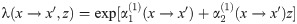
Motion of a single ant on a line.(A) Animals switch between three behavioral states: STOP (gray), UP (blue), and DOWN (red). The transition rates have a form λ(x→x′,z)=exp[α1(1)(x→x′)+α2(1)(x→x′)z] with α1(1)(S→x′)=ln(0.4), α2(1)(S→x′)=0, α1(1)(U→x′)=α1(1)(D→x′)=ln(0.25) and α2(1)(U→x′)=-α2(1)(D→x′)=0.7. A short segment of a sample stochastic trajectory, following Eq (10), is shown together with instantaneous transition rates from the current state. (B) Because tiling functions are used to represent position, the sufficient statistics for the inference are conditional histograms. The first row shows the histograms of the position given behavioral state during the whole simulation. Second row shows the number of transitions from a given behavioral state in each bin. Since from each state transitions can happen into two other states, each of the panels in the second row shows two (almost identical) histograms that correspond to two different color-coded target states. (C) Inferred transition rates (dots; color denotes the target state) from the simulated stochastic trajectories (100 trajectories for t ∈ [0, 500]), compared with the exact transition rates (solid curves; color denotes the current state). Since each state can transition into two other states, the inference provides separate estimates for each transition, shown as two sets of dots of different color. The true rates for two target states are equal.